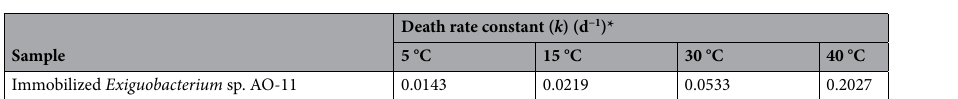
Table 3. Death rate constant ( k ) of immobilized Exiguobacterium sp. AO-11. *Death rate constant ( k ), which refers to the decreasing rate of cell viability at each constant temperature.